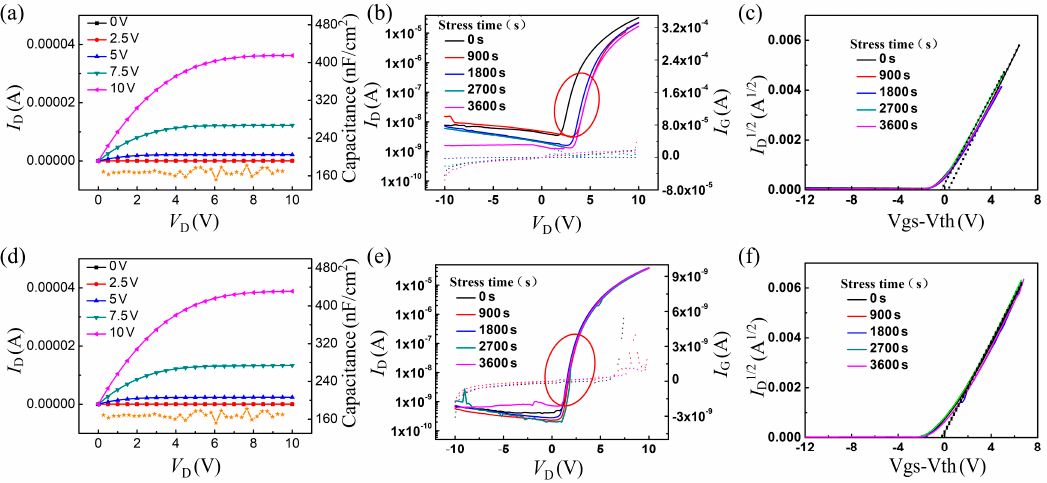
Figure 6. Bias stability of the TFT with ZrO 2 film fabricated by 0.6 M precursor spin-coating 3 times. ( a ) Output curves and gate capacitance as a function of voltage. ( b ) Transfer curves with gate-leakage current curves of positive bias stress. ( c ) Plots of sqrt I ds (drain/source current) versus gate overdrive of positive bias stress. ( d ) Output curves and gate capacitance as a function of voltage. ( e ) Transfer curves with gate-leakage current curves of negative bias stress. ( f ) Plots of sqrt I ds (drain/source current) versus gate overdrive of negative bias stress.